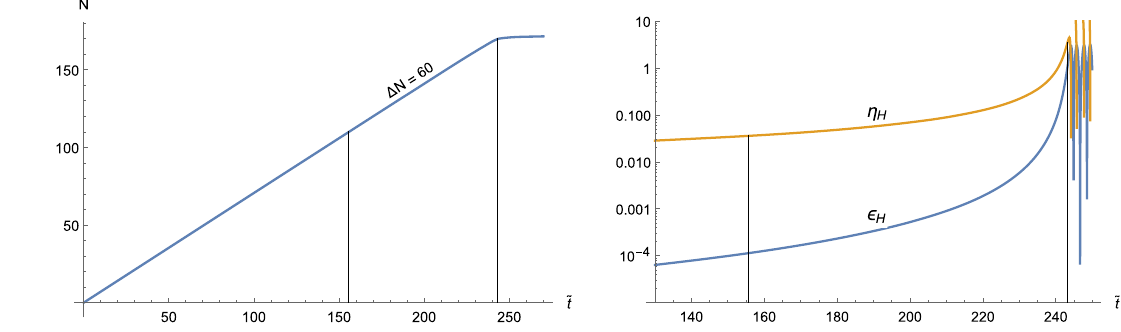
Fig. 4 The number of e-folds (left) and the slow-roll parameters (right) for the solution to Eqs.(30) and (31). The vertical lines represent the last 60 e-folds of inflation